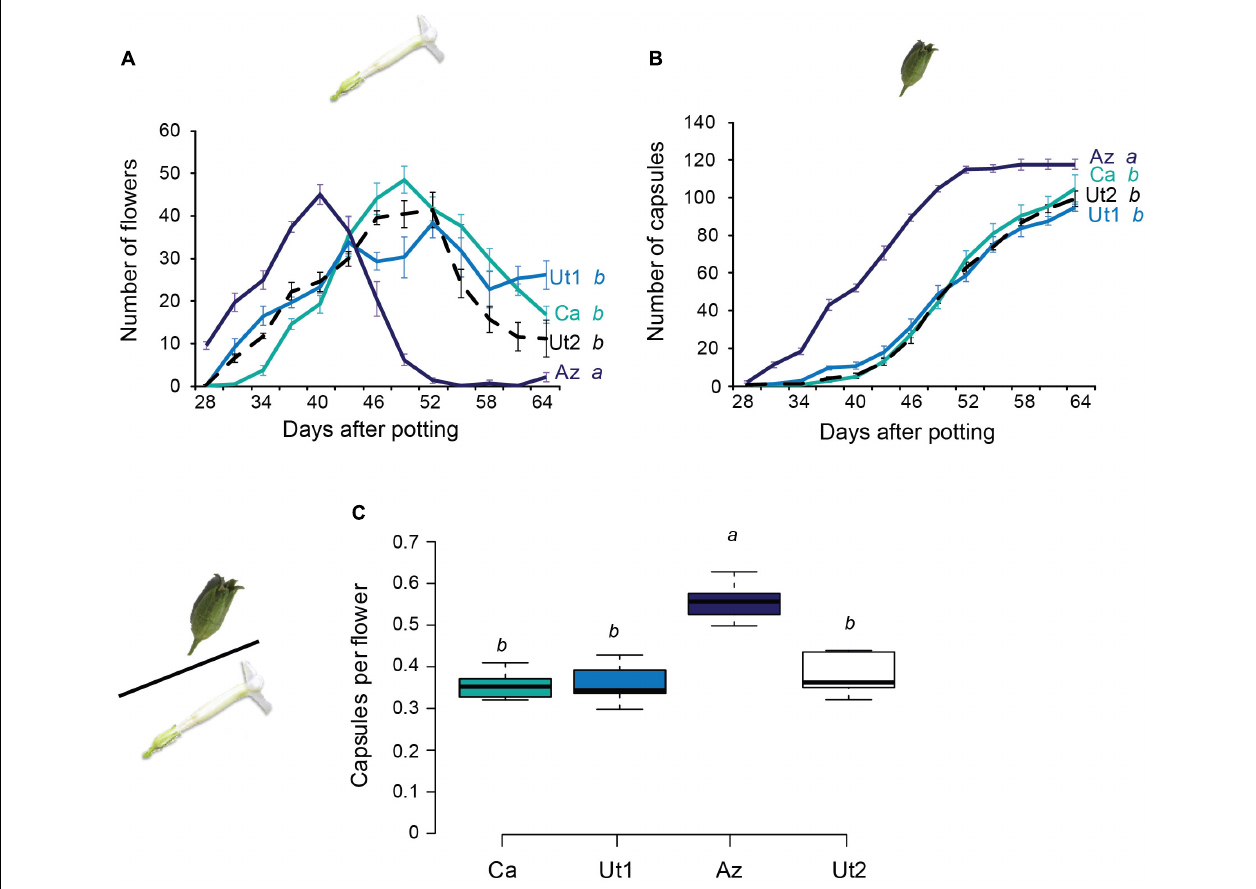
FIGURE 3 | Flower and capsule count over the lifespan of four N. attenuata accessions. (A) Mean ± SEM number of flowers per plant ( N = 5, generalized linear model with polynomial fitting with four terms, followed by least square means for pairwise comparison with Tukey adjustment). (B) Mean ± SEM accumulative number of capsules produced per plant ( N = 5, generalized linear model with polynomial fitting with four terms, followed by least square means for pairwise comparison with Tukey adjustment). (C) Proportion of capsules formed per total number of flowers per plant [ N = 5, generalized linear model (quasi-binominal family) followed by a least square mean pairwise comparison]. Error bars of the boxplot in panel (C) indicate 1.5 times the interquartile range; boxes depict first and third quartiles. Different letters indicate significant differences ( p <